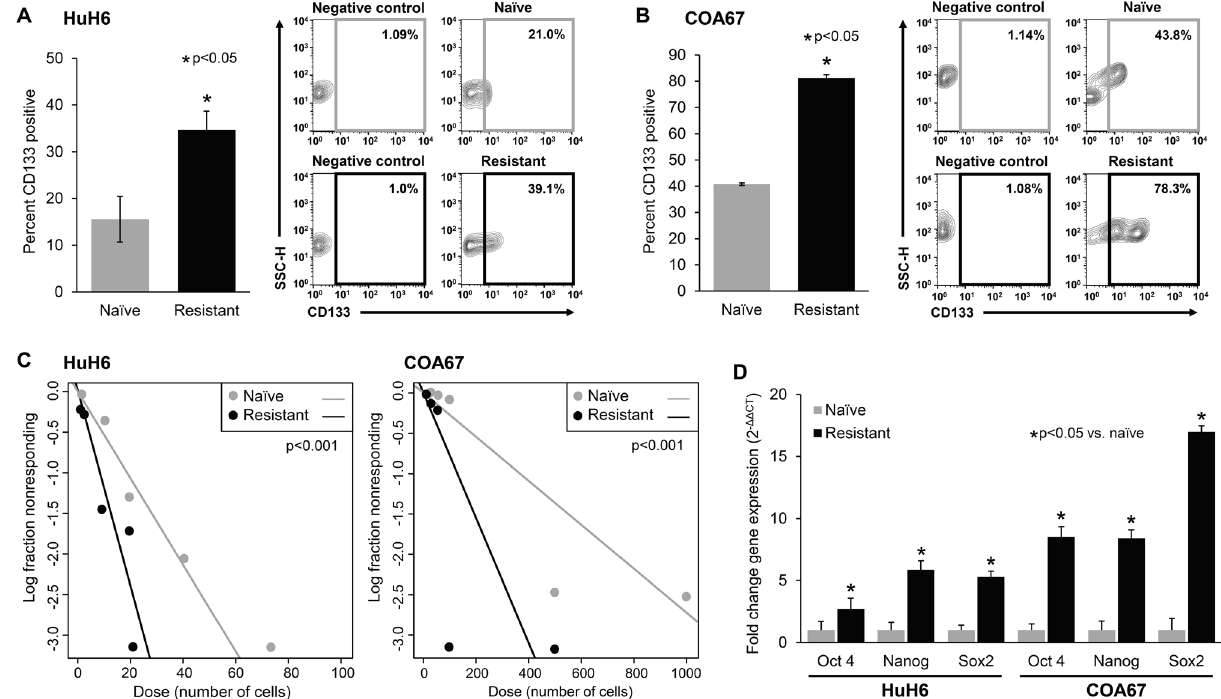
Figure 2. Cisplatin-resistant hepatoblastoma cells have higher frequency of stem cell-like cancer cells (SCLCCs). ( A,B ) CD133 cell surface expression was evaluated by FACS in cells from both cisplatin-naïve and cisplatin-resistant tumors and reported as percent CD133 expression ± SEM. Cisplatin-resistant ( A ) HuH6 and ( B ) COA67 cells had higher expression of CD133. Representative contour plots are shown to the right of the graphs. ( C ) Extreme limiting dilution analysis was performed to evaluate sphere forming ability. Cisplatin- resistant and cisplatin-naïve cells were plated in non-adherent culture conditions at decreasing concentrations of cells (from 5000 to 1 cell per well for HuH6 and 10,000 to 1 cell per well for COA67). After one week, wells were examined by a single blinded researcher and the numbers of wells containing spheres were counted. Sphere forming ability was calculated utilizing the extreme limiting dilution analysis software (http://www.bioin f.wehi. edu.au/softw are/elda/) and a plot of the log proportion of negative cultures vs. the number of cells plated is shown. The slope of the line is the estimated log-active SCLCC fraction. Cisplatin-resistant cells formed spheres more frequently than cisplatin-naïve cells (p < 0.001), indicating increased stemness. ( D ) Quantitative real-time PCR was utilized to assess the mRNA abundance of Oct4, Nanog, and Sox2. Relative abundance of mRNA was calculated using the ΔΔCt method and reported as mean ± SEM of three biologic replicate